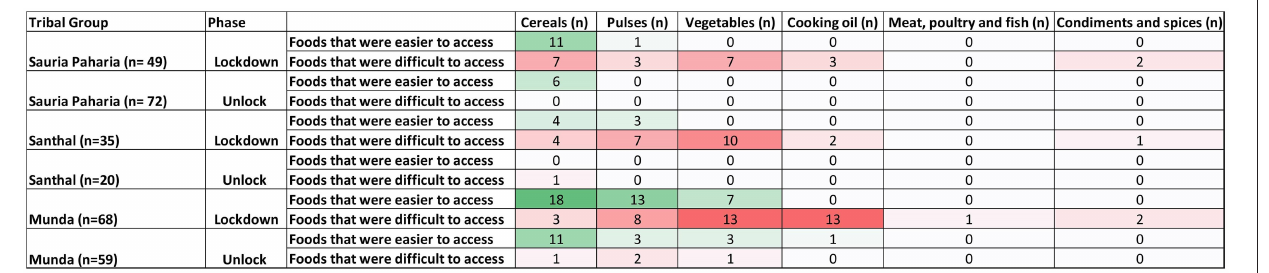
meat, poultry and fish and a couple of Munda HHs ( n =